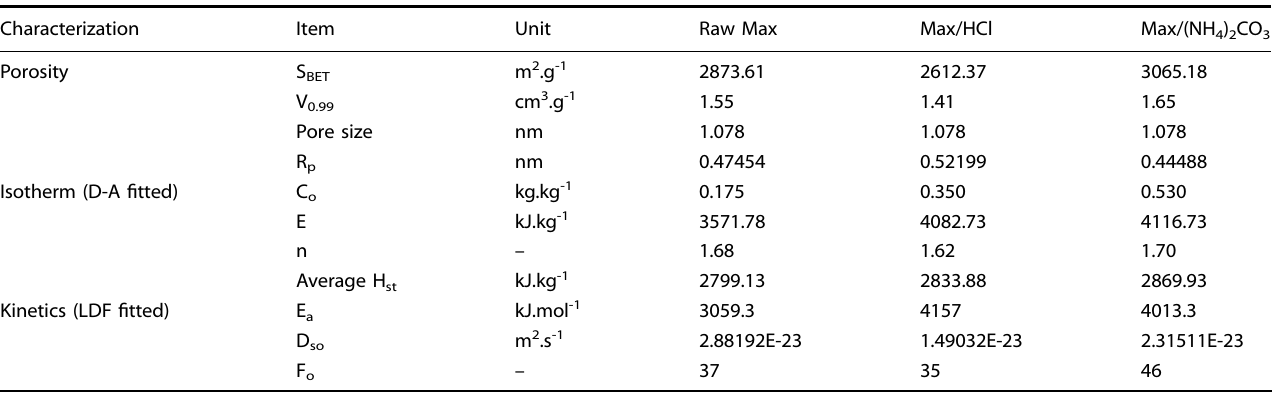
Table 1. Porosity characteristics, D-A, and LDF fi tted parameters of Max samples.